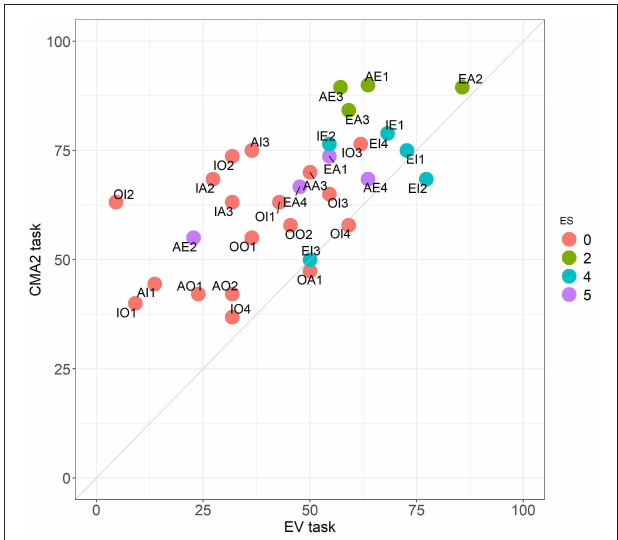
FIGURE 5 | Comparison between the EV and the CMA2 tasks. Performance across the 32 problems. Colors follow the ES classification.